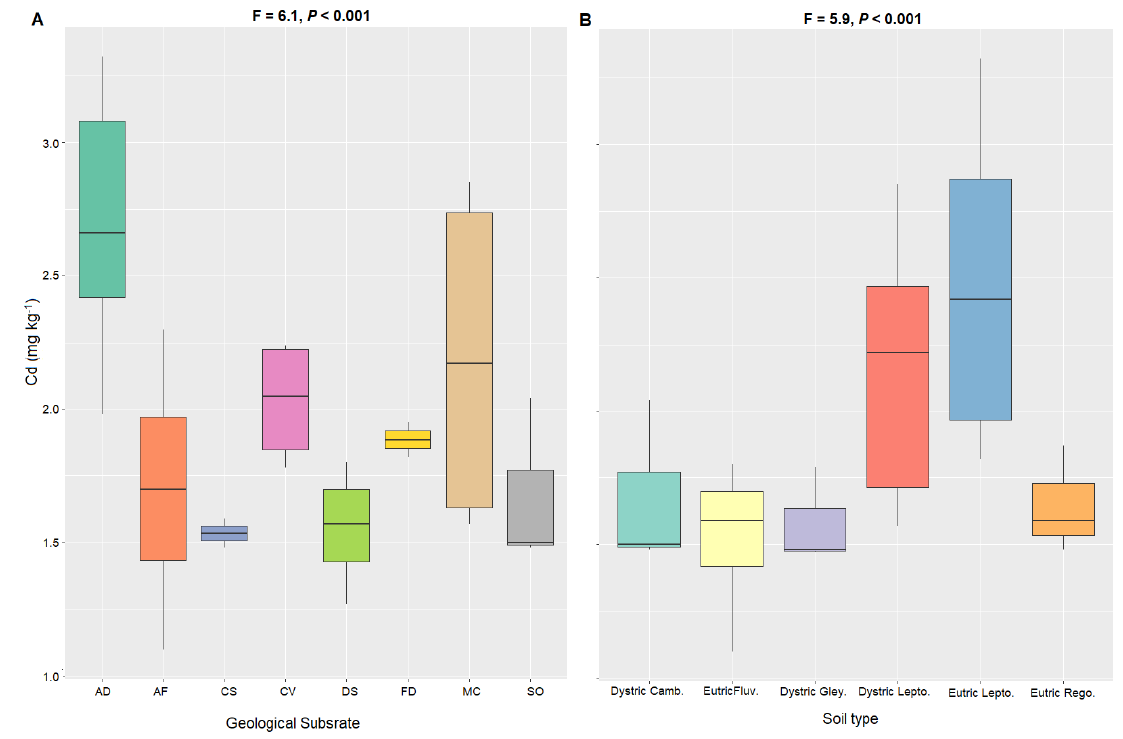
Figure 5. Boxplot of Cd (mg kg − 1 ) ( n = 40) for each geological substrate ( A ): alluvial deposits (AD); alluvial, fluvial, colluvial deposits (AF); carbonaceous schists (CS); clastic and volcanic schists (CV); detritus, sand, and gravel (DS); fluvial deposits (FD); metamorphic complex, sandstones (MC); sandstones, outcrops with silty sand, clay and quartz (SO). Boxplot of Cd (mg kg − 1 ) ( n = 40) for each soil association ( B ): Dystric Cambisol-Haplic Acrisol (Dystric Camb.); Eutric Fluvisol and Gleysol (Eutric Fluv.); Dystric Gleysol and Cambisol (Dystric Gley.); Dystric Leptosol-Cambisol-Regosol (Dystric Lepto.); Eutric Leptosol-Cambisol-Regosol (Eutric Lepto.); Eutric Regosol-Haplic Calcisol (Eutric Rego.)